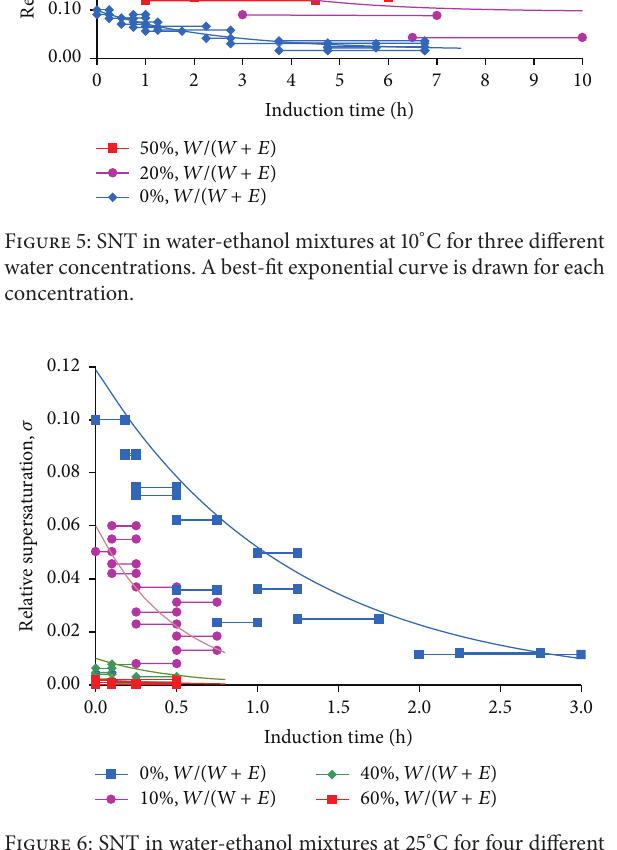
Figure 6: SNT in water-ethanol mixtures at 25 ∘ C for four different water concentrations. An exponential curve is drawn for each concentration.